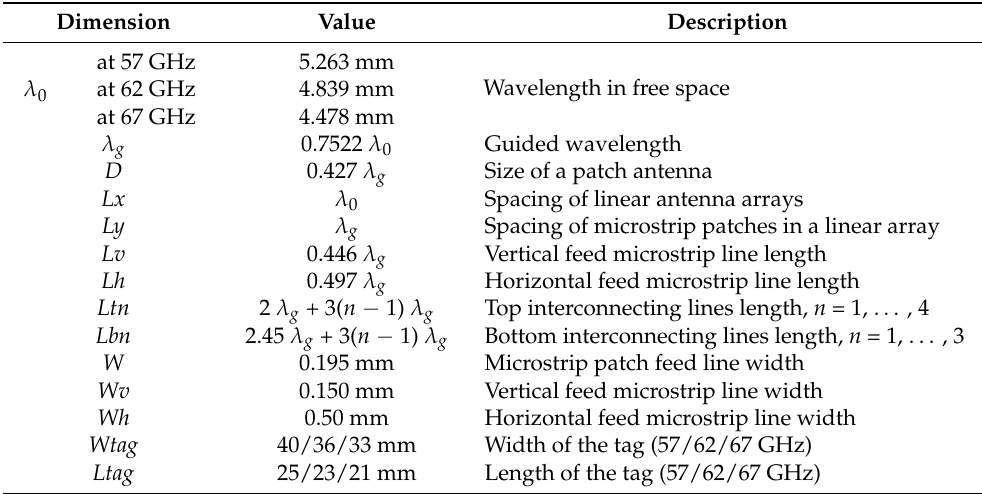
Figure 4. The cross-polarized Van Atta array: ( a ) design and dimensions, and ( b ) photograph of the manufactured tag. Table 2. Cross-polarized tag